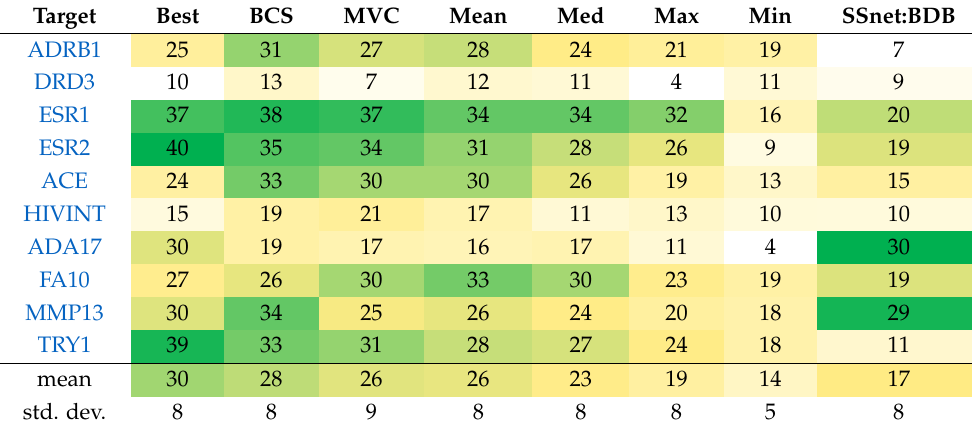
Table 6. EF 1% comparison on consensus